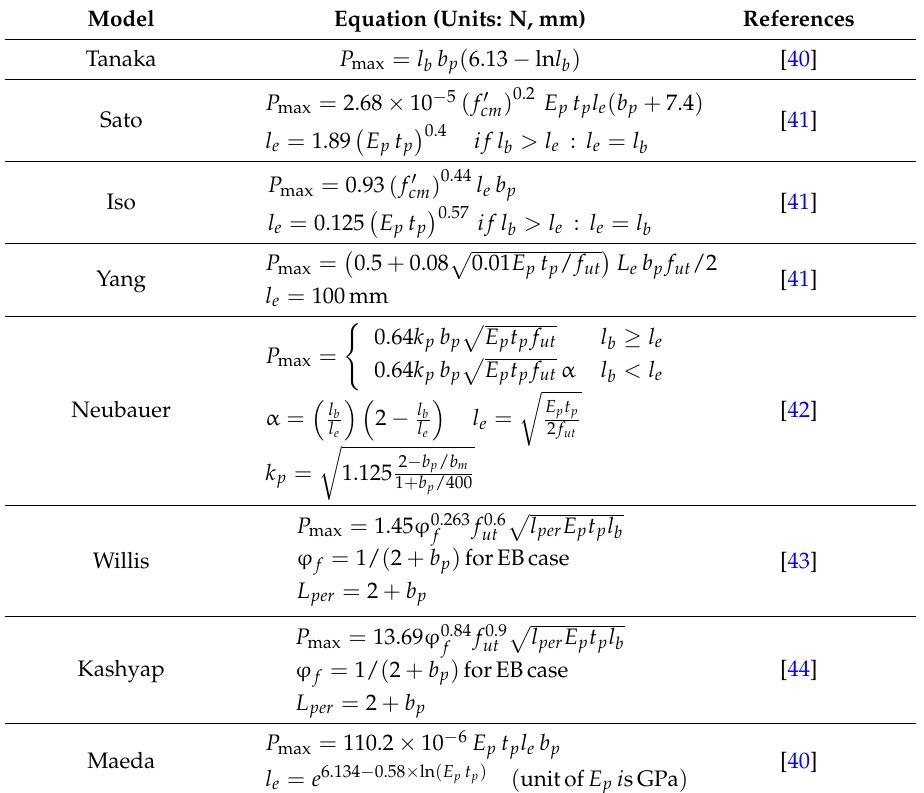
Table 1. Analytical models for the evaluation of the (fiber-reinforced polymer) FRP-masonry bond